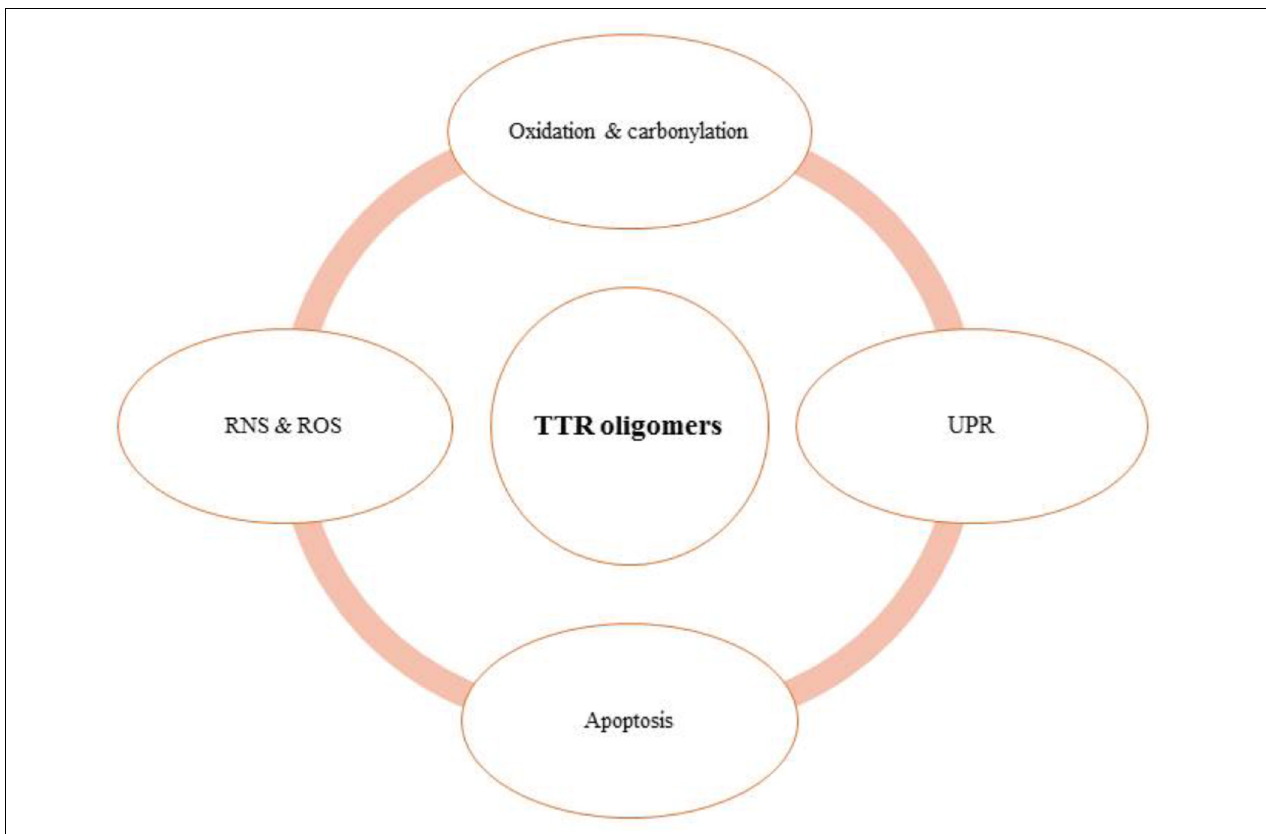
FIGURE 2 | TTR oligomers are linked with various pathophysiological